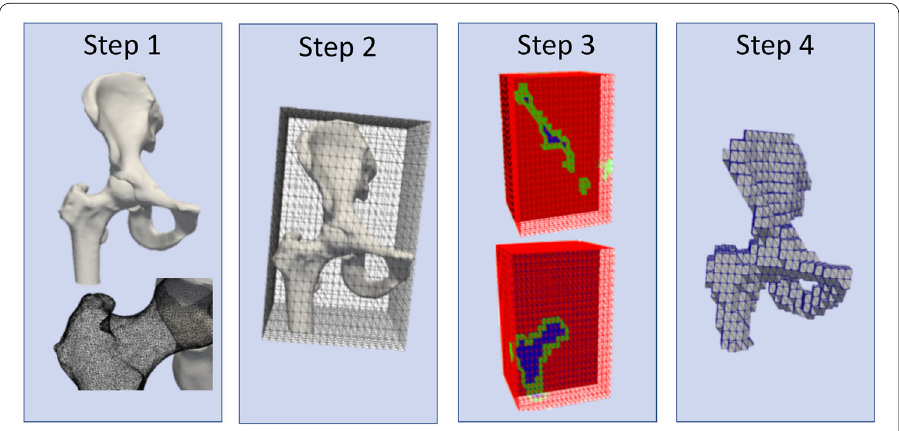
Fig. 3 Illustration of the first 4 steps in the surface triangulation to level set algorithm. The surface triangulation is first embedded in a regular background grid (Step 2). The cells are then marked depending on if they are inside, intersected or outside of the femur and hip bone geometries (Step 3). All cells which are inside or intersected by either the femur or the hip bone geometry are extracted (Step 4)